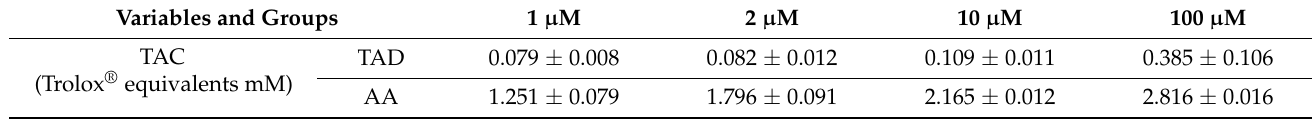
Table 7. Tadalafil total antioxidant